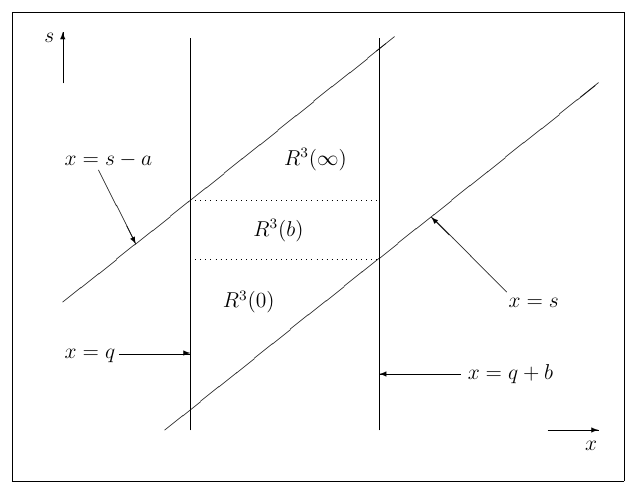
Figure 2. A computer drawing of the state space of the process ( X,S,Q ), for some q